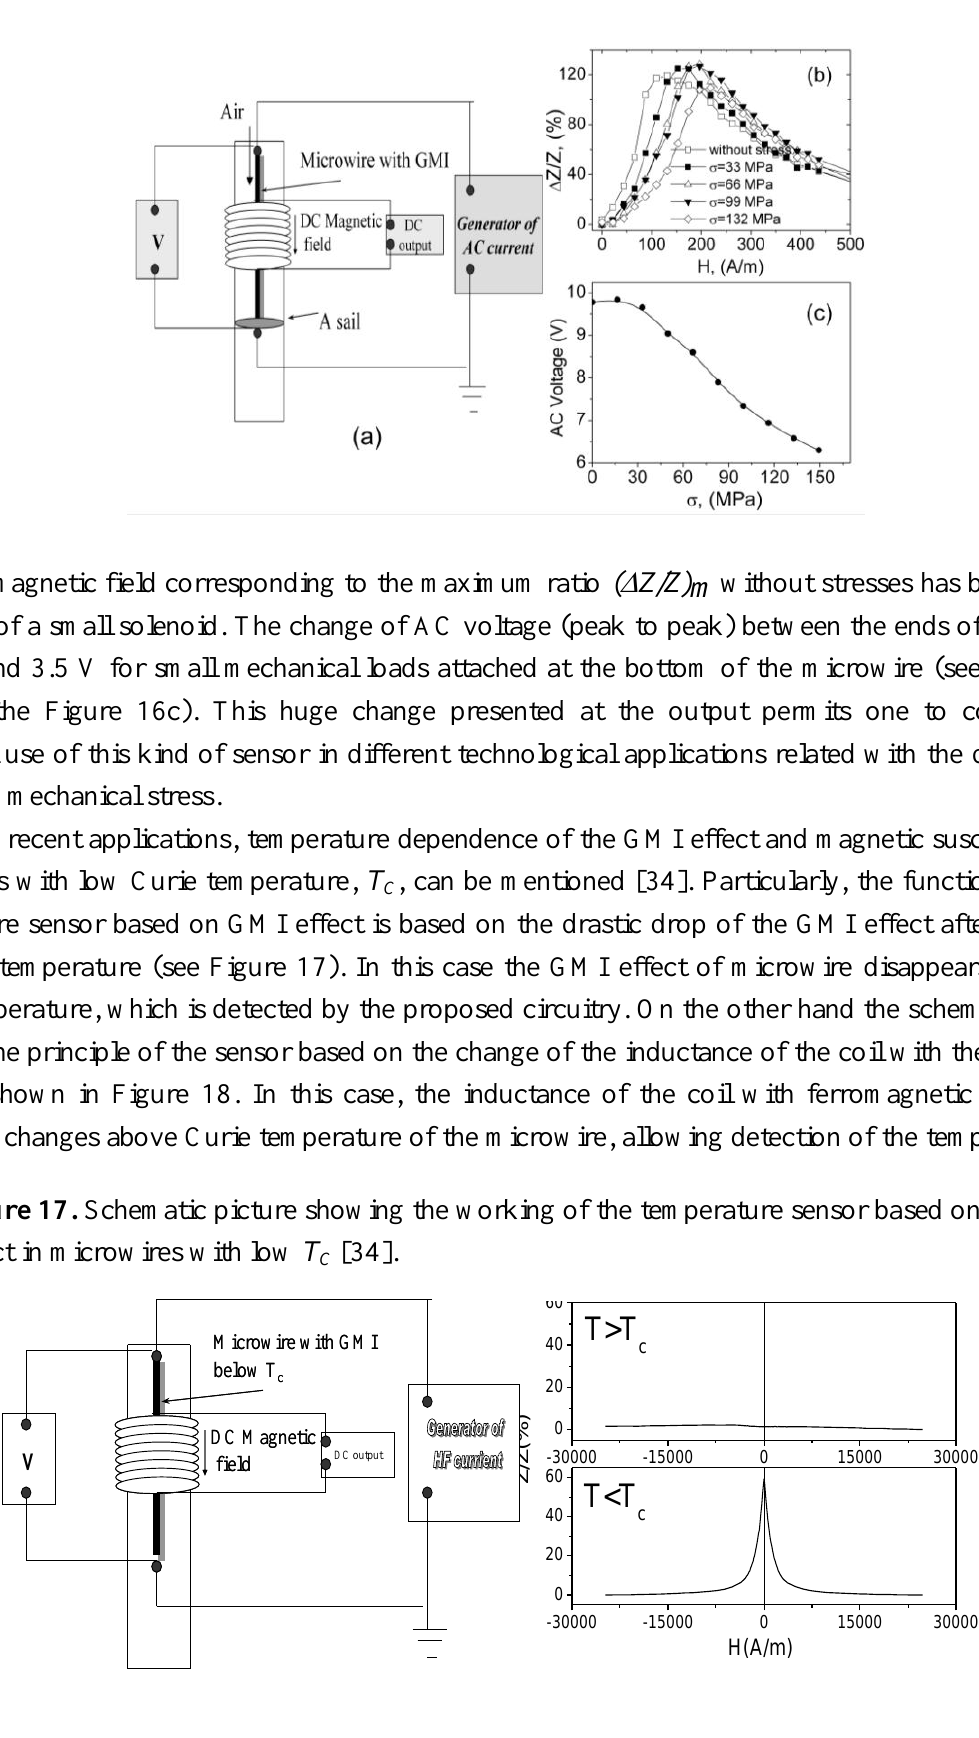
Figure 16. Schematic representation of the magnetoelastic sensor based on stress dependence of GMI effect (a),  Z/Z(H) dependencies of CoMnSiB amorphous microwire measured at different applied stress (b) and calibration curve of sensor (c) [55].